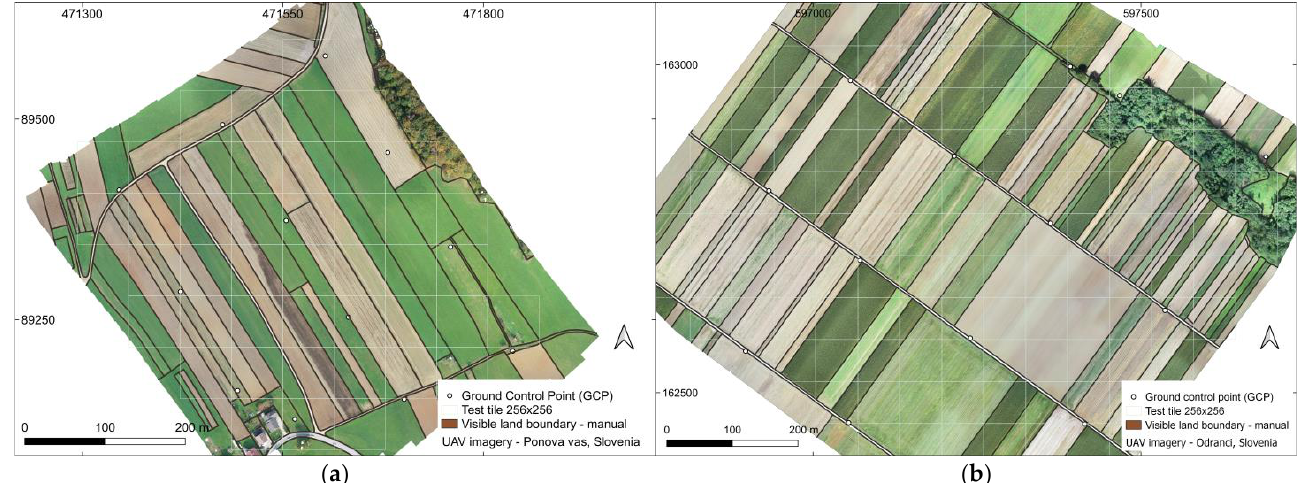
Figure 3. Manually delineated visible land boundaries; ( a ) UAV orthoimage with ground sampling distance (GSD) of 0.25 m Ponova vas, Slovenia; ( b ) UAV orthoimage with GSD of 0.25 m for Odranci, Slovenia; ( a , b ) (EPSG 3794).